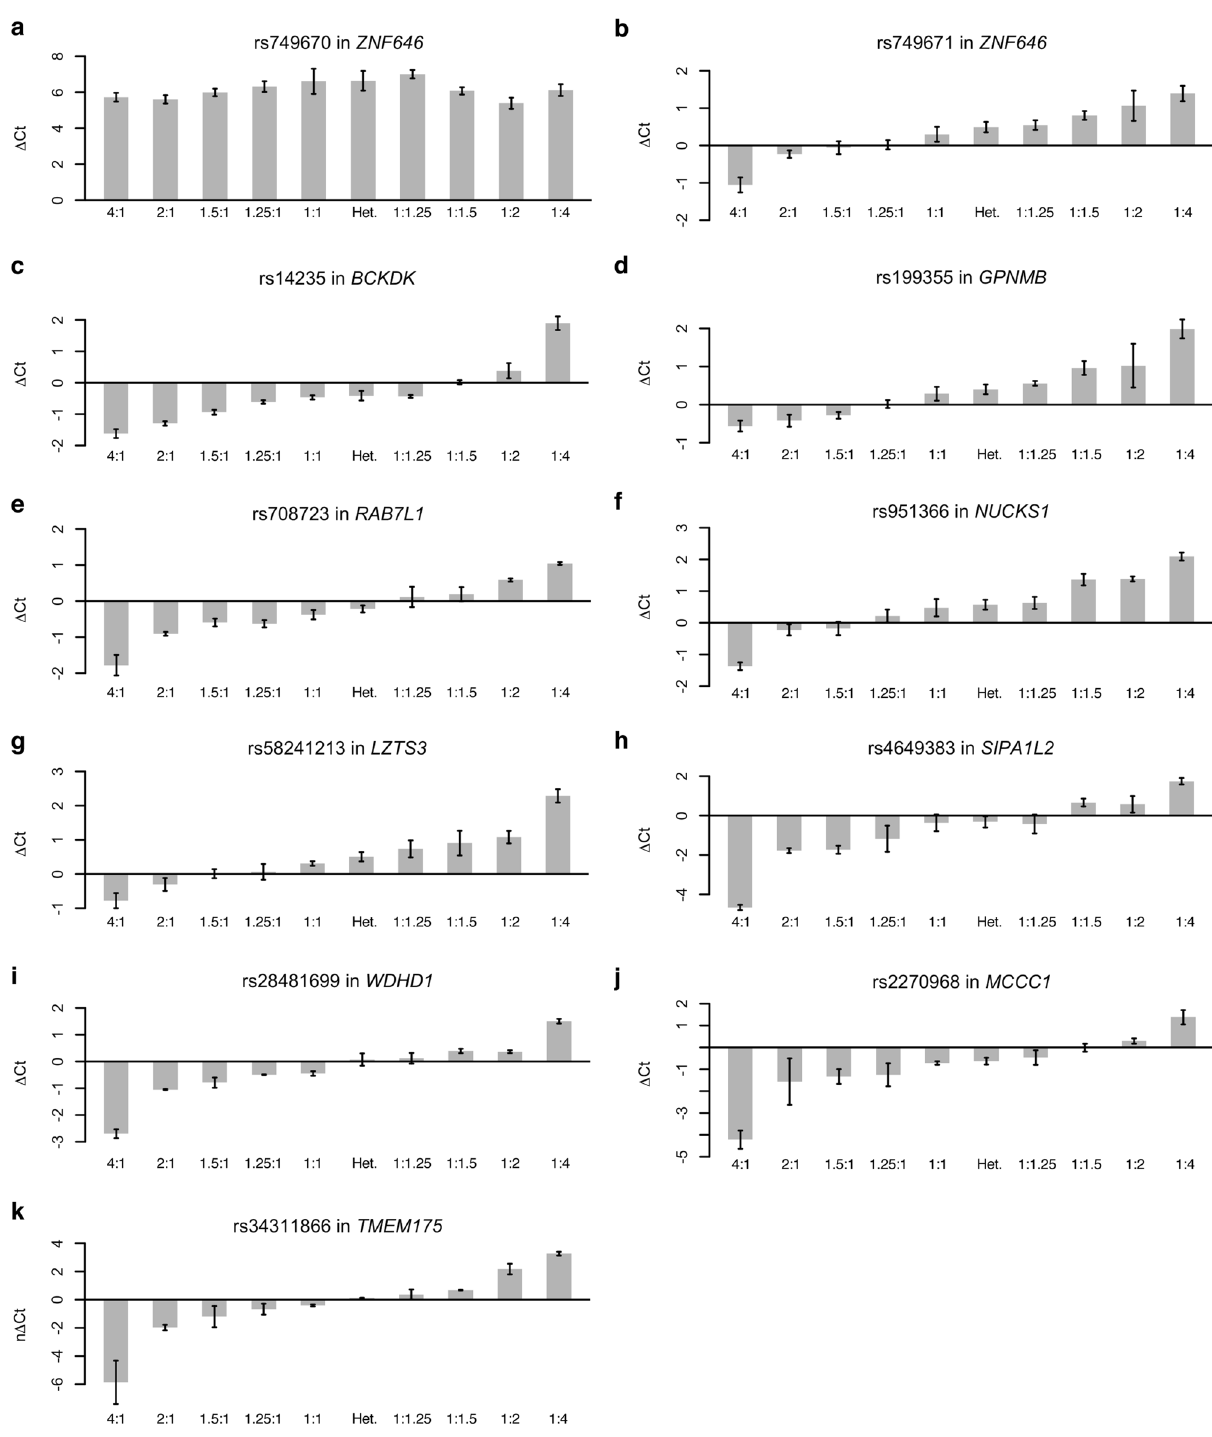
Figure 2. Sensitivity assessment of genotyping assays measuring allelic expression with known ratios of the alleles. Homozygous samples of genomic DNA mixtures at known ratios were tested for ( a ) rs749670 in ZNF646 , ( b ) rs749671 in ZNF646 , ( c ) rs14235 in BCKDK , ( d ) rs199355 in GPNMB , ( e ) rs708723 in RAB7L1 , ( f ) rs951366 in NUCKS1 , ( g ) rs58241213 in LZTS3 , ( h ) rs4649383 in SIPA1L2 , ( i ) rs28481699 in WDHD1 , ( j ) rs2270968 in MCCC1 , and ( k ) rs34311866 in TMEM175 using real-time qPCR. A heterozygous (Het.) sample was included as a 1:1 ratio control as well as allele ratios 4:1, 2:1, 1.5:1, 1.25:1, 1:1, 1:1.25, 1:1.5, 1:2, and 1:4. Three assays (for SNPs rs34884217 in TMEM175 , rs2230288 in GBA , and rs76179989 in STK39 ) could not be tested due to a lack of homozygous samples for one of the alleles. Data are presented as mean change in Ct between the two alleles (ΔCt). Samples were run in triplicates and error bars show the standard error of the mean. qPCR quantitative PCR, Ct cycle